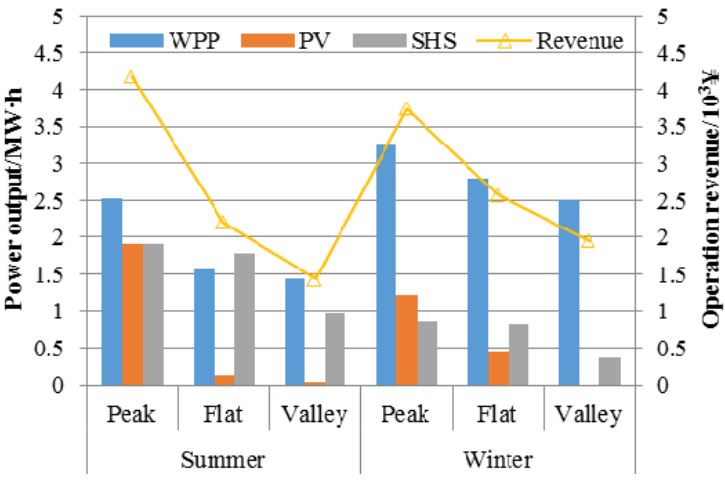
Table 2. Scheduling results of VPP operation in typical load day.